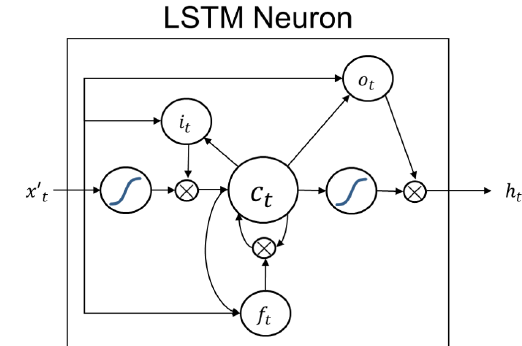
Figure 3. LSTM neuron with cell state c t , as well as input i t , out- put o t and forget f t gates. x (cid:48) t and h t indicate the inputs and outputs of the neuron, respectively. The curves represent sigmoid gates, σ